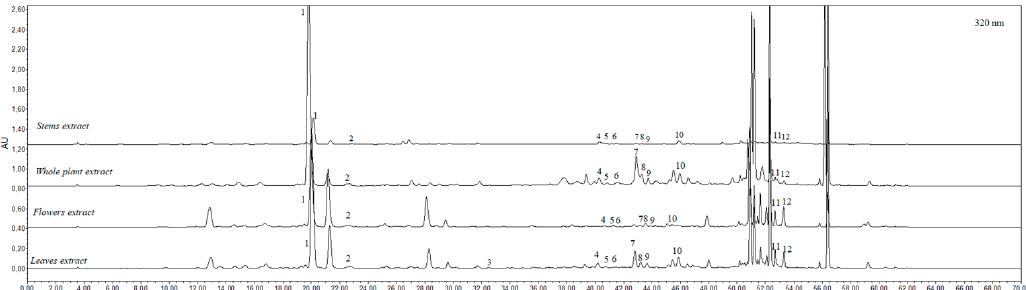
Figure 4. E. ciliata leaves, stems, flowers, and whole herb extracts phenolic profiles at 320 nm wavelenght: 1—chlorogenic acid, 2—caffeic acid, 3— p -coumaric acid, 4—rutin, 5—hyperoside, 6— luteolin-7- O -glucoside, 7—avicularin, 8—apigenin-7- O -glucoside, 9—quercitrin, 10—rosmarinic Table 1. Quantitative composition (mg / g of DW) of determined quercetin glycosides in E. ciliata ethanolic